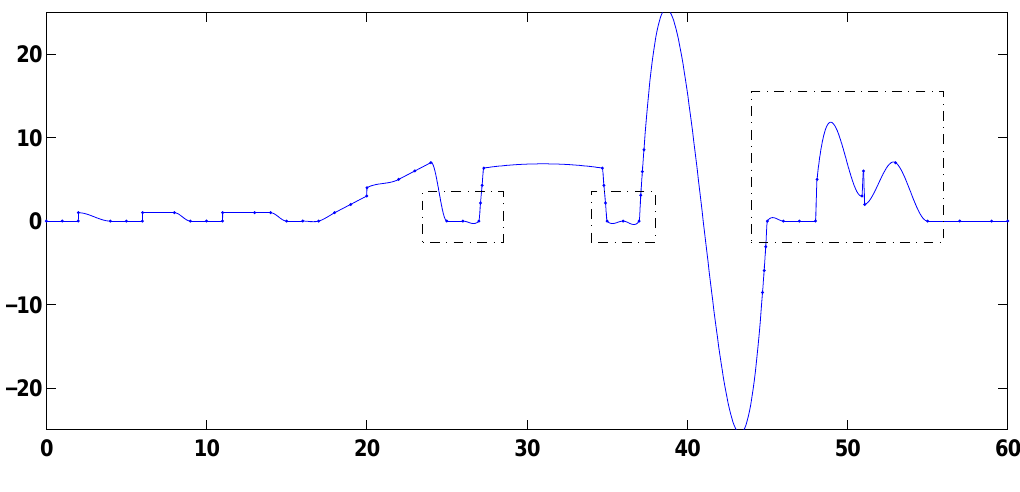
Figure 12 . Antiderivative-based 7-point-window L